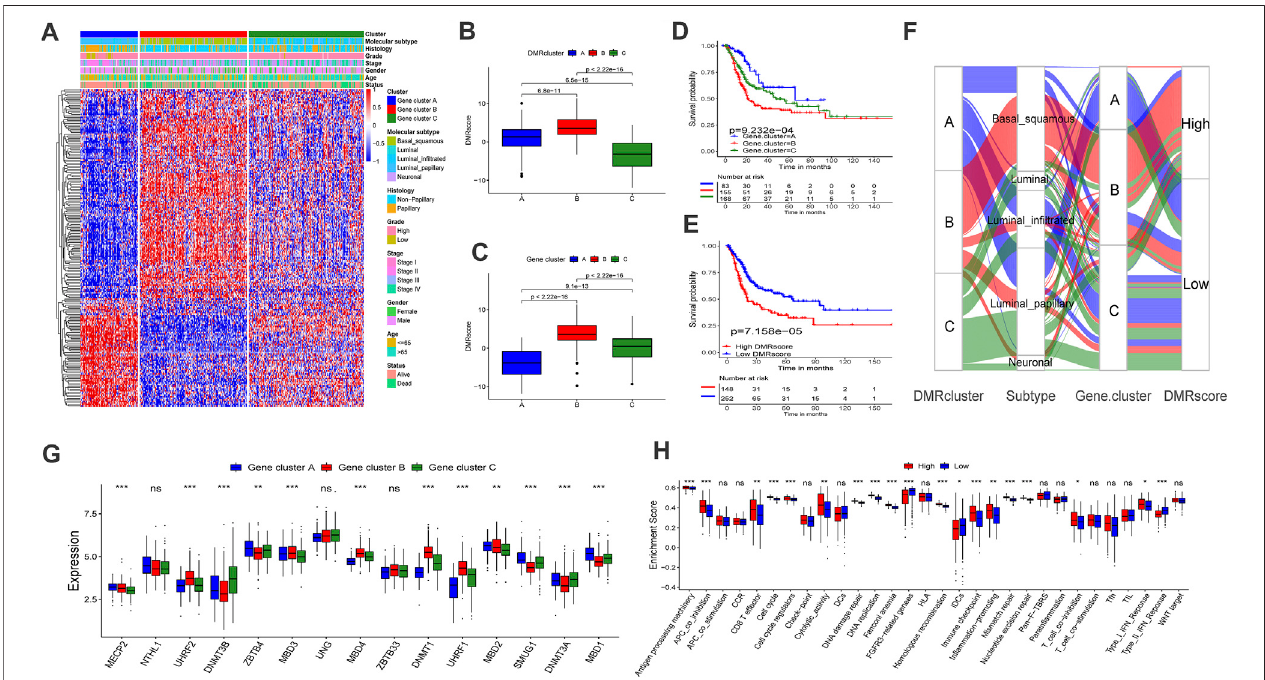
FIGURE 4 | Construction of DNA methylation signatures for individual sample. (A) The heatmap help us to observe the transcriptome landscape among different Gene.clusters (TCGA-BLCA cohort). Gene.cluster subtypes, Molecular subtypes, Histology, Grade, Stage, Gender, Age and Survival status were used as patient annotations. Red represented high expression level and blue represented low expression level. B-C Differences in DMRscore among three DMRclusters (B) or Gene.clusters (C) in TCGA-BLCA cohort (Kruskal-Wallis test, p < 0.001). D-E Kaplan-Meier curve displayed a remarkable difference among three Gene. clusters ( (D) , p < 0.001) or DMRscore subgroups ( (E) , p < 0.001) in TCGA-BLCA cohort. (F) Sankey diagram displayed the alteration of DMRclusters, molecular subtypes, Gene.cluster and DMRscore. (G) The transcriptome characteristics of 15 DNA methylation regulators among Gene.clusters. Gene.cluster (A) : blue box; Gene.cluster (B) :redbox.Gene.clusterC:greenbox.Themedianvalue:blacklinesinboxes,theoutliers:blackdotsoutboxes. (H) Differencesintheknowngenesignaturesbetween high DMRscore and low DMRscore subgroups. APC: antigen-presenting cells. The asterisks represented the statistical p value (* p < 0.05; ** p < 0.01; *** p <